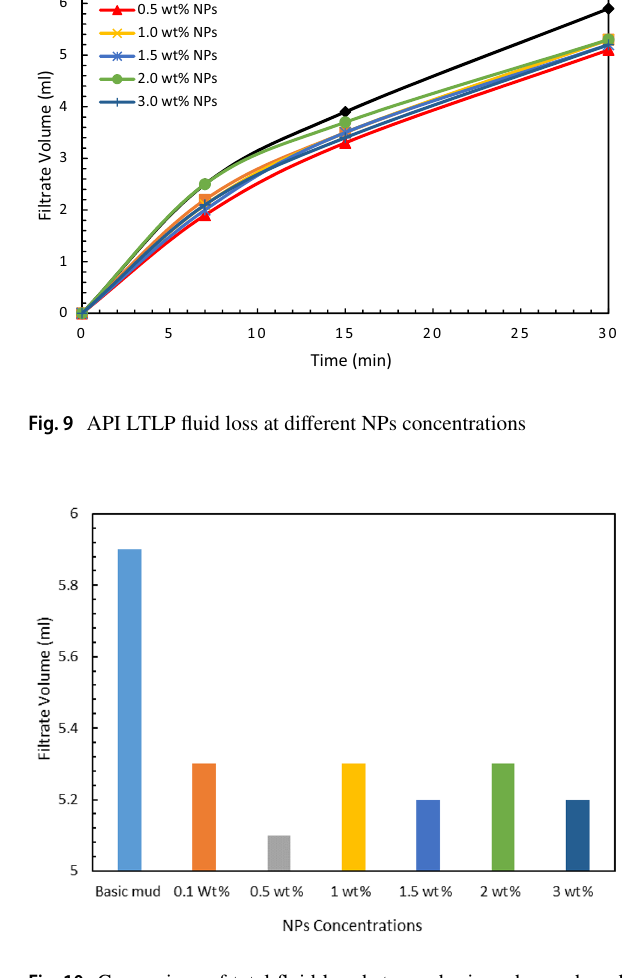
Fig. 10 Comparison of total fluid loss between basic and nano-based mud at 30